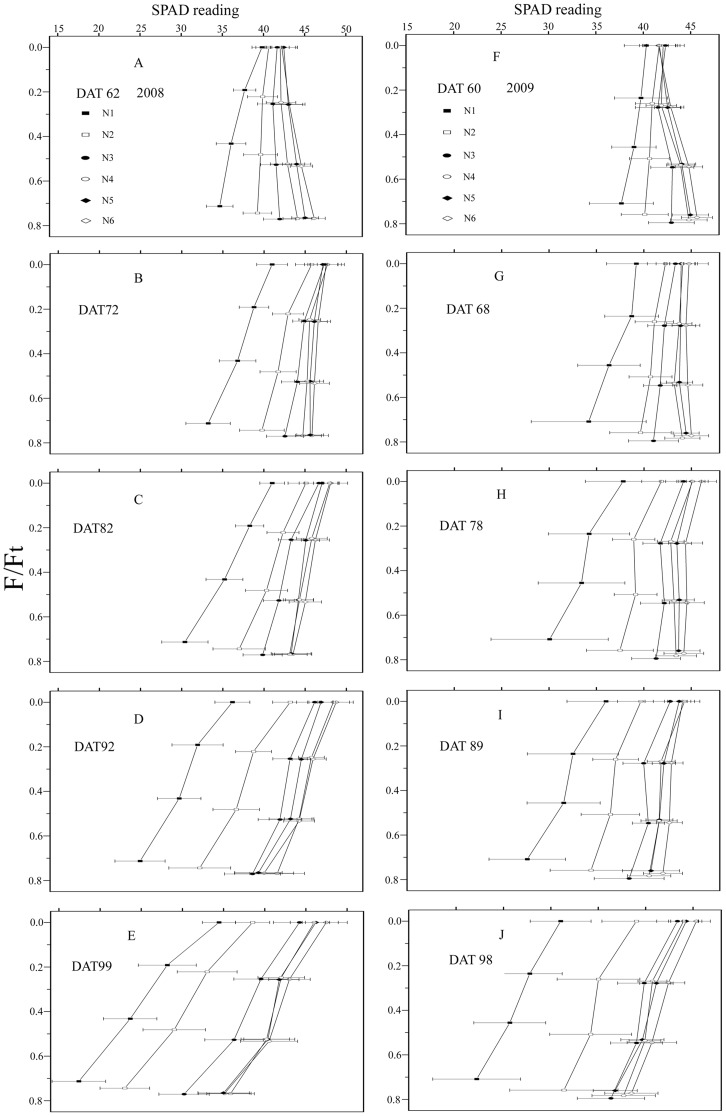
Temporal changes in the distribution of SPAD readings of rice plants grown under six N application rates during (A - E) 2008 and (F - J) 2009.
F is the cumulative leaf area index (LAI) from the top of the canopy, Ft is total LAI; F/Ft is the relative LAI. Each value is an average of 30 measurements. Bars indicate standard error of means. N1 to N6 are the same as in the legend in Fig. 1.